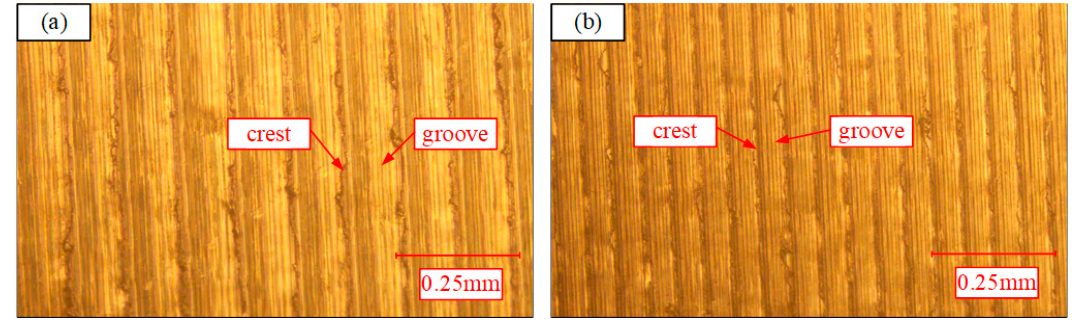
Figure 23. Microscopic images of the surface: ( a ) LEC mode; ( b ) LSR mode.